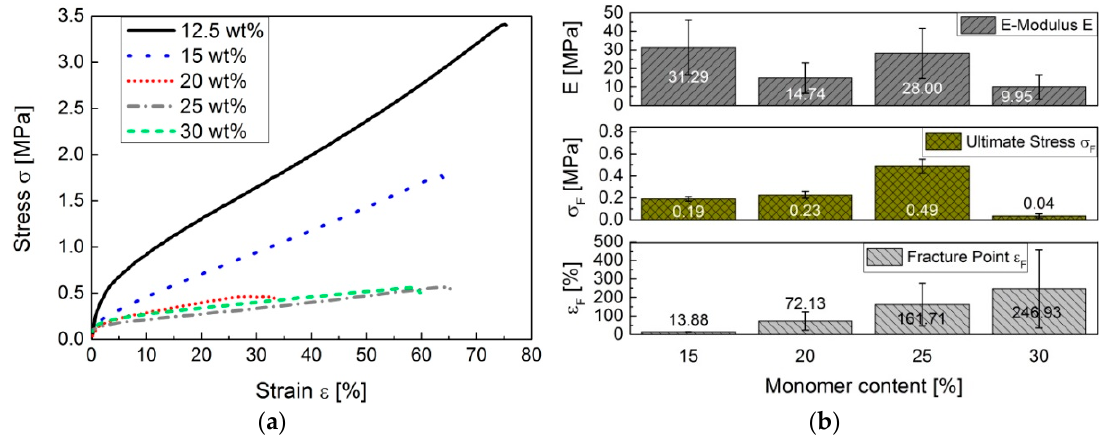
Figure 12. Ductility experiments of the pS-DVB specimens: ( a ) stress–strain diagram; ( b ) ductility parameters ( E -Modulus E , Ultimate Stress σ F and Fracture Point ε F ).